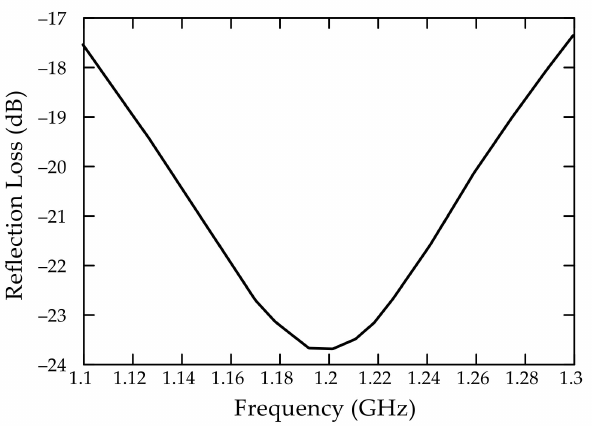
Figure 5. Computer simulation of reflection loss versus frequency for an absorber panel whose 13 mm thick absorber layer consists of 50% polycarbonate resin and 50% BaTiO 3 + BiFeO 3 (at weight ratio of 1/3) (after [39]).